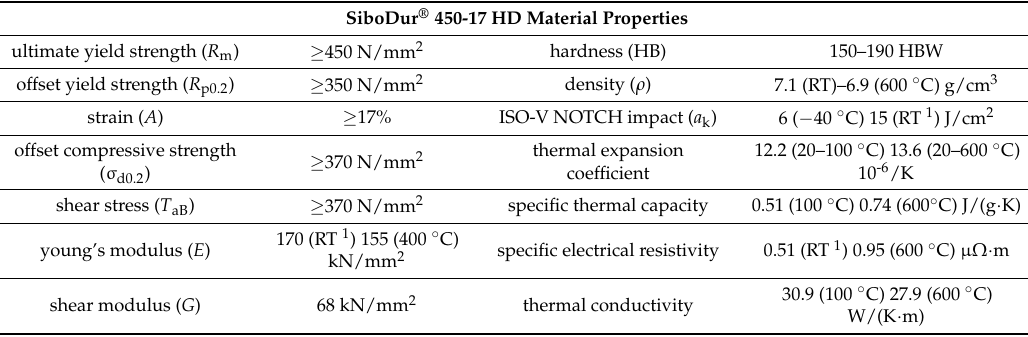
Table 1. SiboDur ® 450-17 HD main material properties [18].